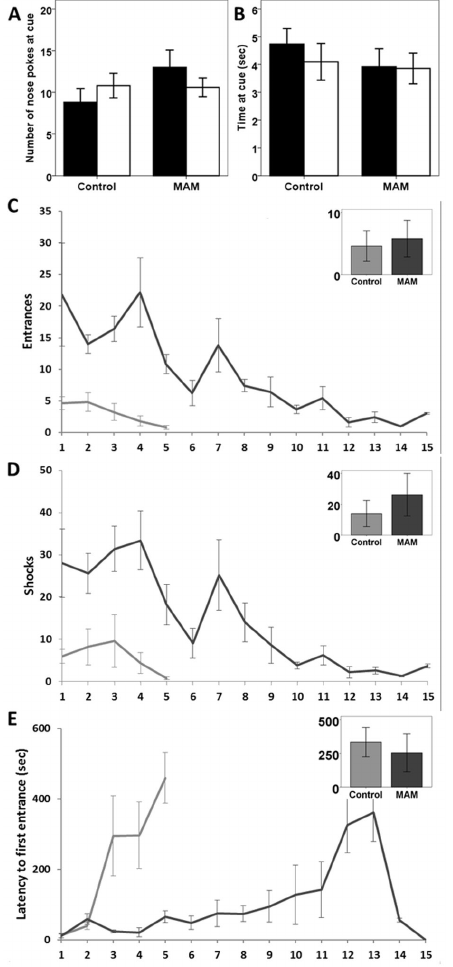
Figure 3. Control and MAM treated animal’s data from the place avoidance task. Control and MAM had similar levels of exploration of the two local cues (white and black) as measured by ( A ) nose pokes and ( B ) time spent at the cue. The controls (grey line) decrease entrances into the zone ( C ) and number of shocks ( D ) far more quickly than MAM (black line), but both decreased the number of entrances (p<0.001) and shocks (p<0.001) over time. ( E ) Latency to first entrance is a measure of how long an animal takes to enter the shock zone from the start of the session. MAM has significantly shorter latencies (p<0.001). Inset graphs show number of entrances, shocks, and latency for the probe session. In the probe, the black and white local cues were transposed and the shock was turned off, but entries and “shocks” that would have been delivered were still counted. This allowed us to infer the rat's strategy toward shock avoidance. Avoidance of the original shock quadrant would indicate place learning, where the location of the shock zone is defined by a configuration of multiple cues. Avoidance of the black cue would indicate stimulus-response learning, where the black cue card was associated with shock. Control and MAM both largely avoided the original shock zone rather than the black local cue.